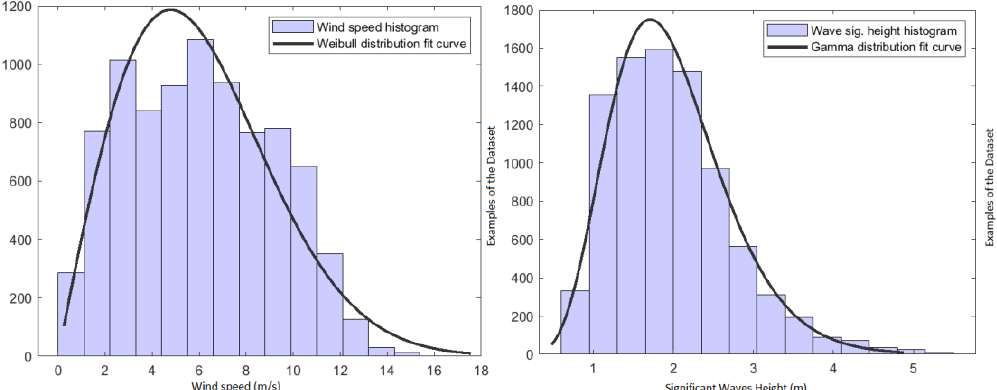
Table 4. Statistical measures of wind and wave variables.